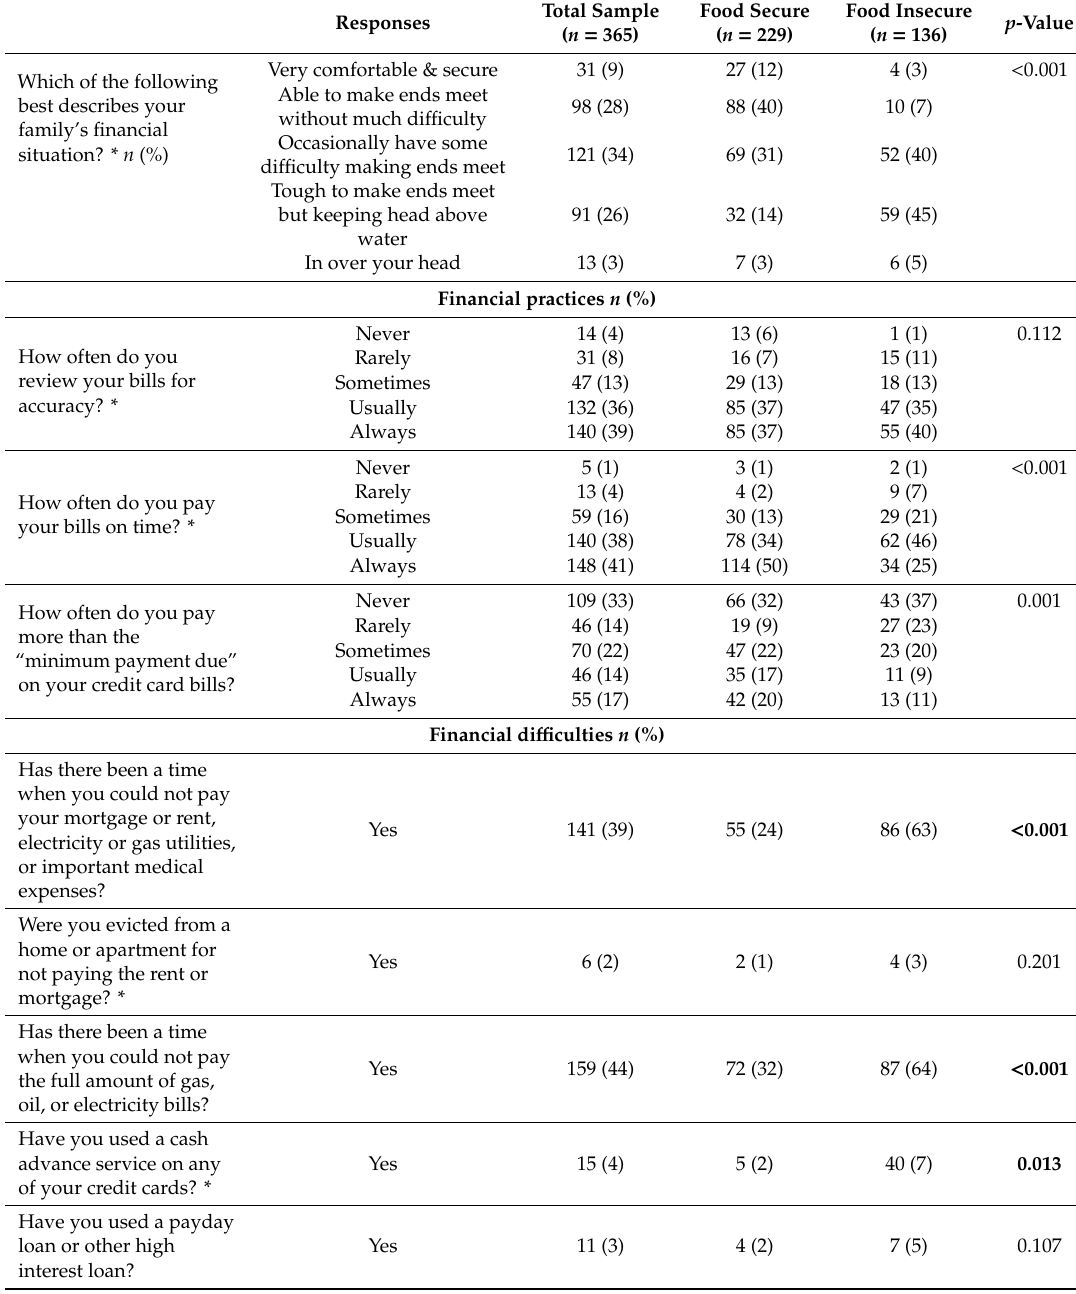
Table 3. Financial situation, practices and di ffi culties of Head Start caregivers in the study sample and by household food insecurity ( n = 365) 1